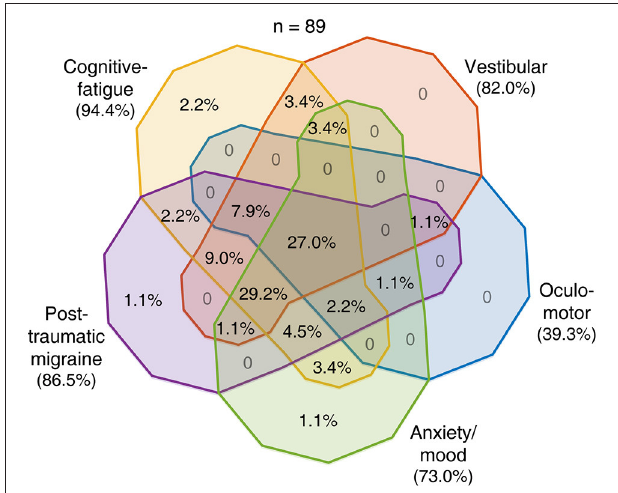
FIGURE 4 | Overlaps in post-concussion profile characteristics identified with at-least mild symptoms . All 89 concussed subjects reported having an at-least mild post-concussion symptom. The distribution of these 89 subjects among the various combinations of presences and absences of endorsement of the five symptom classes is shown as percentages in the Venn